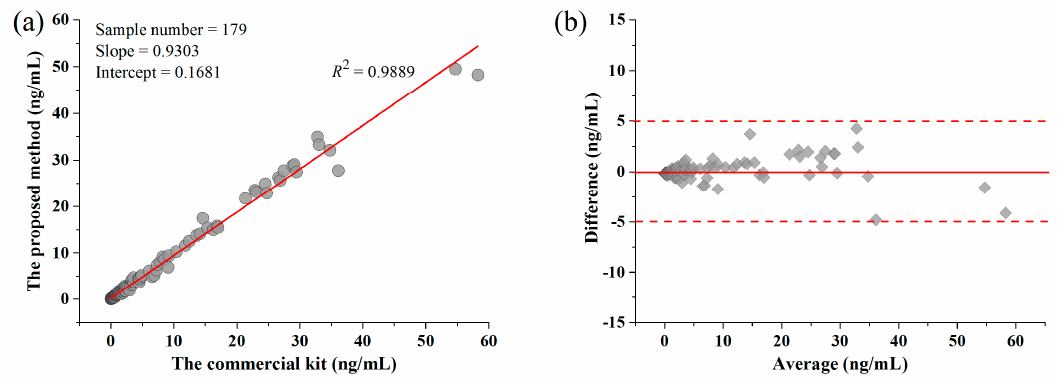
Figure 6. The results clinical test of cTnI ( a ) and the average difference ( b ).